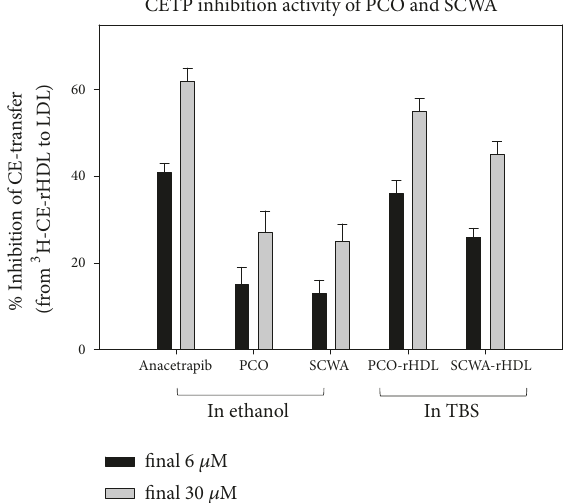
Figure 4: CETP inhibition activity of policosanol (PCO) or sugar cane wax acid (SCWA) in ethanol and rHDL. Data are expressed as mean ± SD of three independent experiments performed in duplicate. CE transfer from [ 3 H]-HDL (50 𝜇 g of apoA-I, 30,000 CPM) to human LDL (50 𝜇 g of protein) by human HDL 3 (25 𝜇 g of protein) was inhibited by rHDL containing policosanol. TBS, tris-buffered saline.